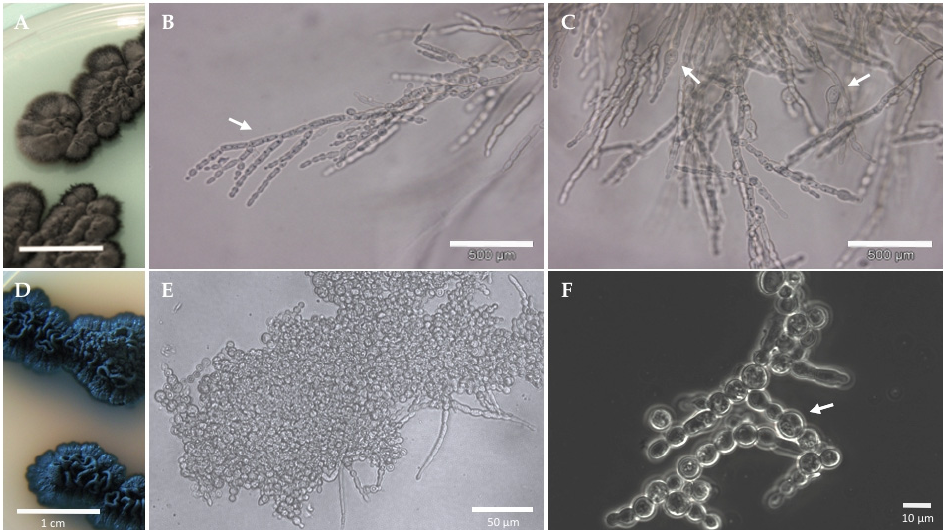
Figure 3. Growth forms observed in black yeasts and black fungi. The black yeast Exophiala dermatitidis ( A – C ); The microcolonial rock-inhabiting fungus Knufia chersonesos ( D – F ). Olive-brown colonies growing on 2% malt extract agar (MEA) ( A ); Nuclei and hyphal growth are visible in ( B ), Isodiametric expansion (swelling) in hyphal cells is shown in ( C ). Black, cerebriform colonies growing on 2% MEA ( D ); Clusters of cells occasionally branching into torulose hyphae ( E ); Swelling observed in torulose hyphae ( F ).